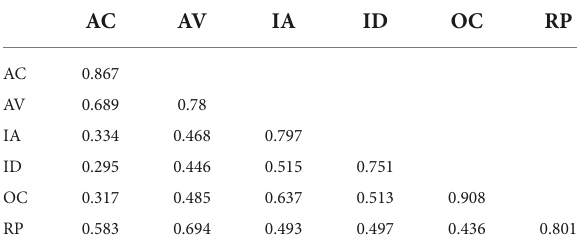
TABLE 2 Fornell-Larcker criterion.